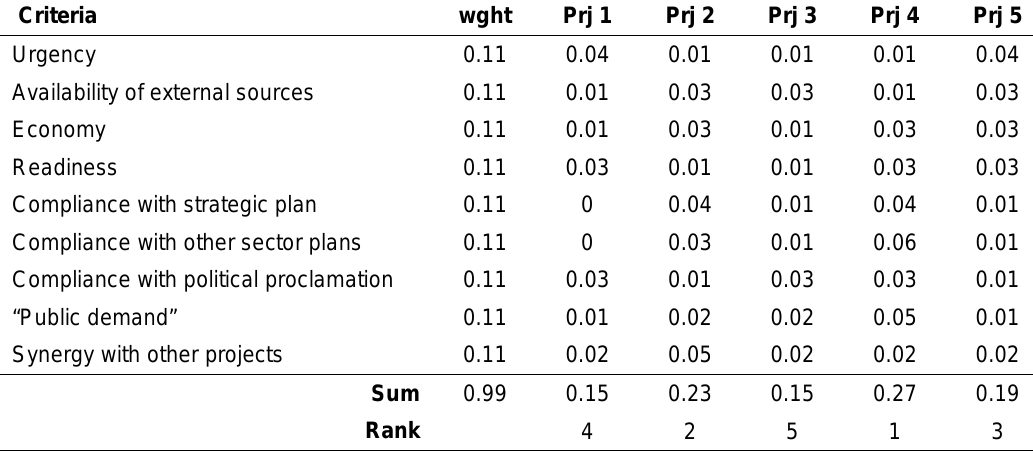
Table 6. Results of AHP